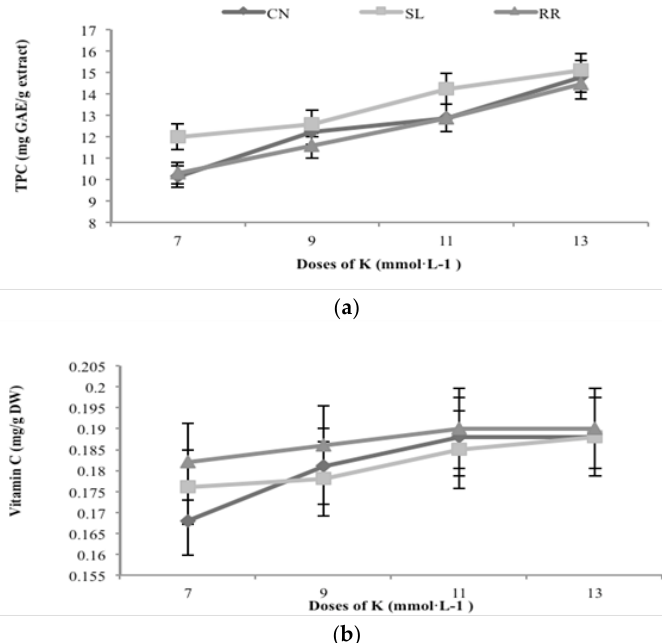
Figure 2. ( a ) Effects caused by the interaction of genotype and doses of K + (G × DK) for the Total Phenolic Compounds (TPC) of hydroponic basil; ( b ) Effects caused by the interaction of genotype and doses of K + (G × DK) for the content of Vitamin C of hydroponic basil; CN: “Cinnamon”; SL: “Sweet Lemon”; RR: “Red Rubin”. GAE: Gallic Acid Equivalent. Interval bars are standard error.